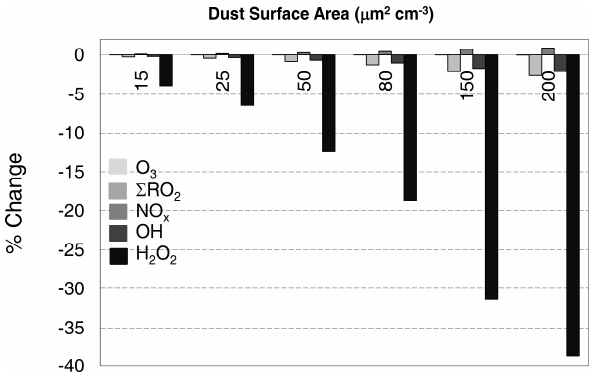
Fig. 6. The increase in H 2 O 2 loss as a function of increasing dust exposure relative to the control run with no heterogeneous loss (filled circles). The e -folding lifetime of H 2 O 2 is also shown with respect to dust exposure (filled triangles).